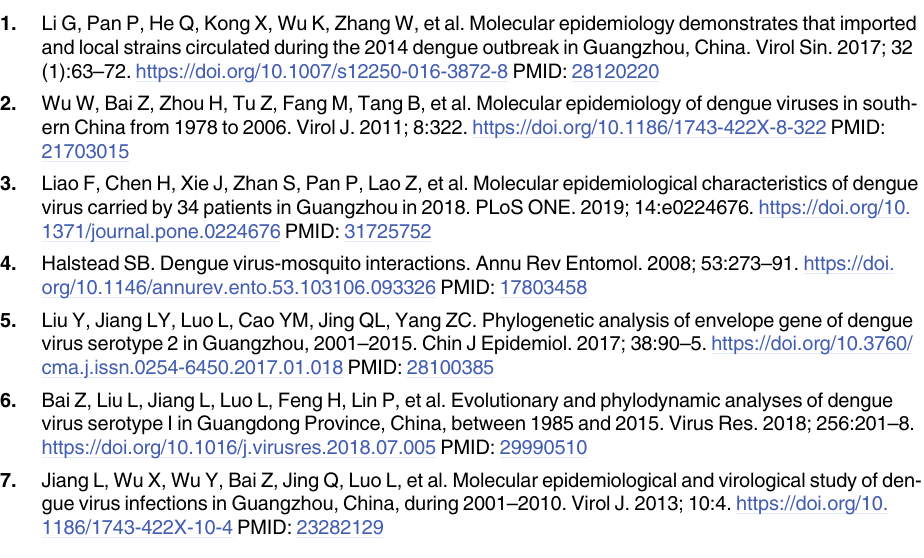
Fig 1. Maximum-likelihood phylogenetic tree shows the evolutionary relationships of DENV-2 detected in the sera of 2 local cases along with 45 other sequences. The reference sequences are named using the GenBank accession number, country, and year. The sequences of strains isolated in Guangzhou are named using the GenBank accession number, year, and our lab number. Bootstrap support values are shown in the notes. Strains isolated in 2020 are indicated with a black